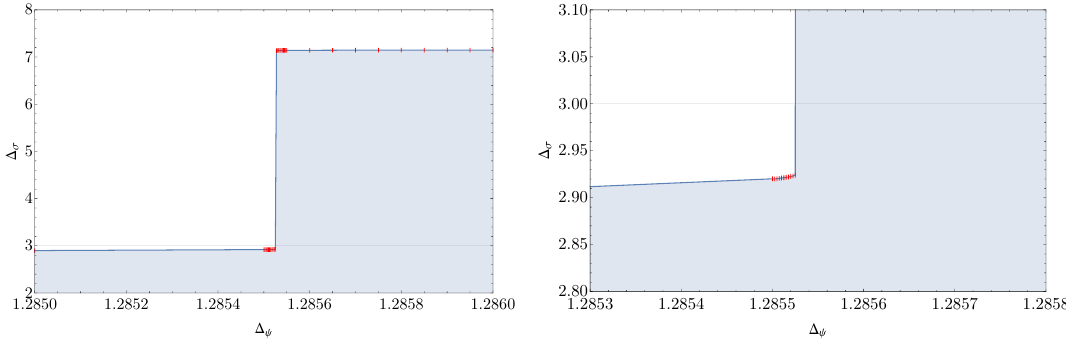
Figure 2 : Zoom-in of the bound on ∆ lines show the positions of sample points in ∆